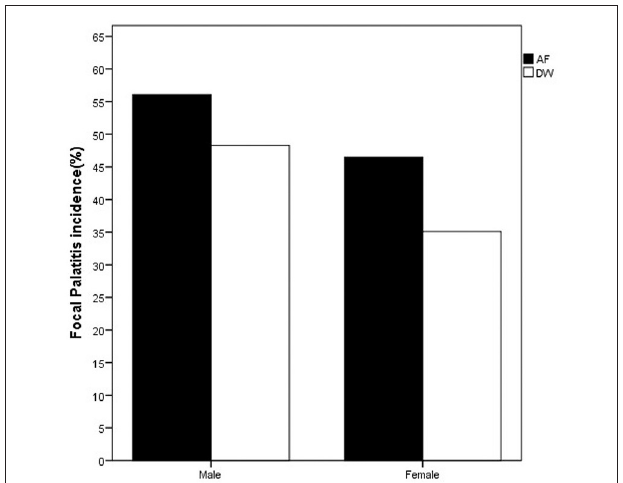
FIGURE 1 | Bar chart depicting the frequency (%) of FP seen at first visit in the cheetahs of the two facilities evaluated. FP was present in cheetahs from both